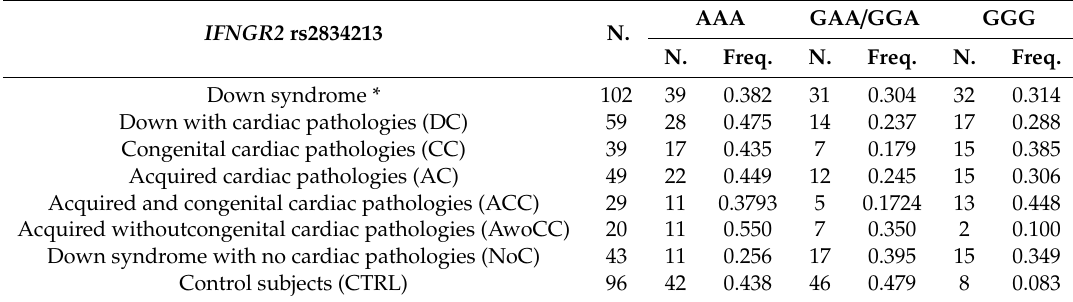
Table 5. IFNGR2 rs2834213 genotype frequencies of patient with Down syndrome (DS) and control groups. IFNGR2 rs2834213 N.